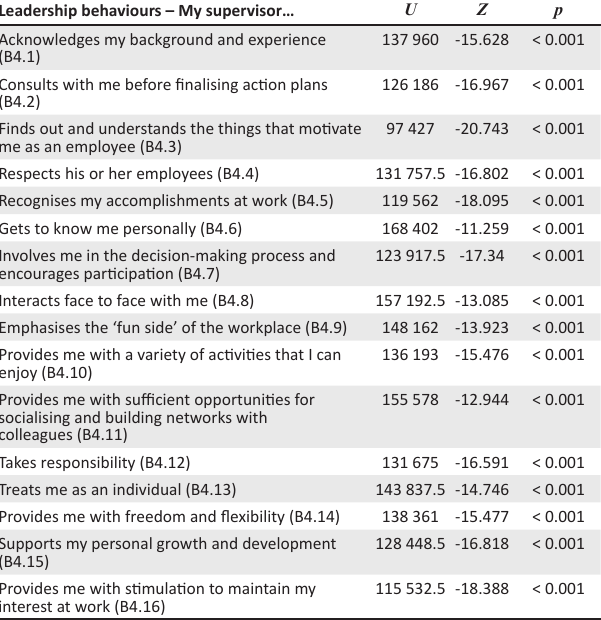
TABLE 3: Mann–Whitney U test for difference between the importance and experience of leadership behaviours. Leadership behaviours – My supervisor…